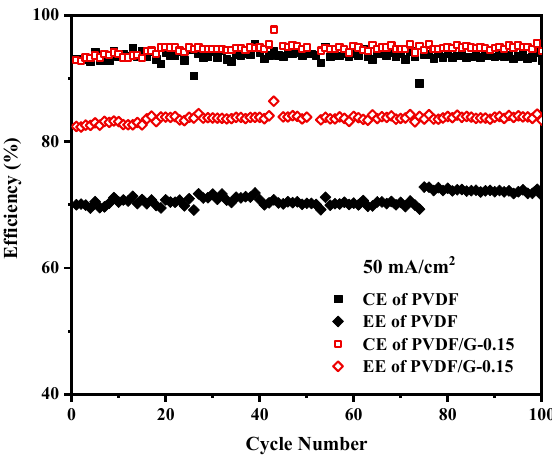
Figure 10. Battery performance assembled with PVDF and PVDF/G-0.15 membranes at 50 mA/cm 2 .